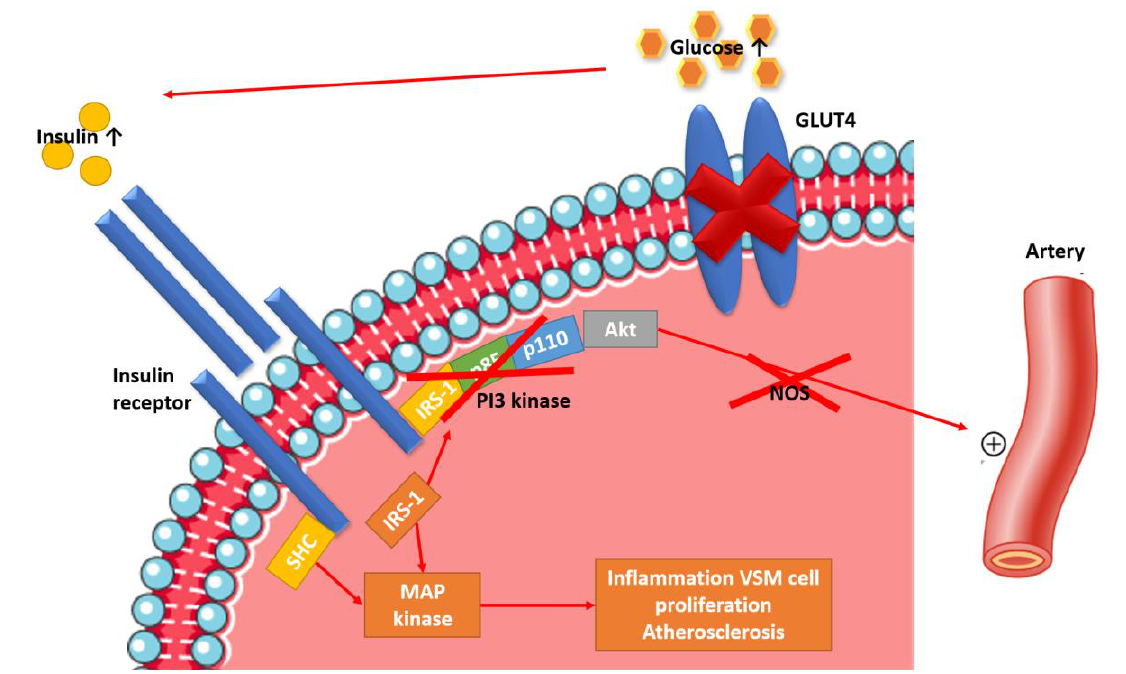
Figure 1. Pathophysiological mechanisms linking IR and hypertension in children with DM. The signaling is impaired at the level of IRS-1, therefore, glucose transport is decreased and nitric oxide synthase activation is impaired, leading to decreased NOS production and therefore vasocon- striction. At the same time, insulin signalling through the MAPK pathway remains normally sensi- tive to insulin. For this reason, compensatory hyperinsulinemia (secondary to insulin resistance in the IRS-1/PI3K pathway) causes excessive stimulation of the MAPK pathway, which is involved in inflammation, vascular smooth muscle cell proliferation, and atherogenesis. Abbreviations: NOS — nitric oxide synthase; SHC — Src homology collagen.